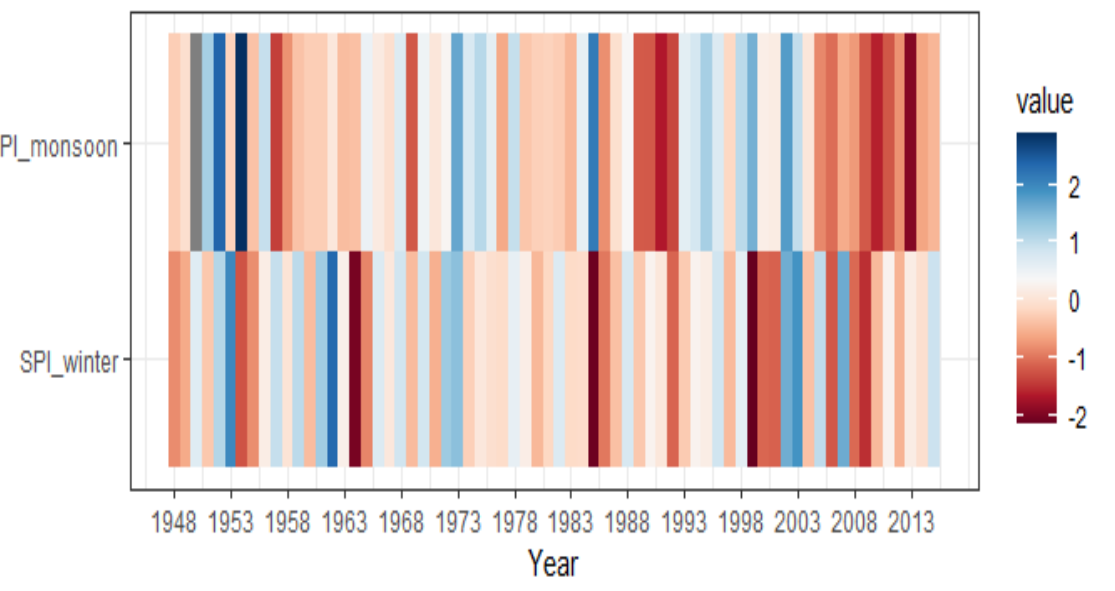
Figure 7. Drought heat map of Standard Precipitation Index SPI (SPI 1 to SPI 12) in the study area. The drought heat map showed the monsoon drought (four-month SPI in September) and winter drought (three-month SPI in February) (Figure 8). Results suggested that both monsoon and winter droughts occurred on a periodic basis, and after 2004 there were consecutive monsoon drought years in the study area. The wet/non-drought conditions (SPI > 0) were indicated by shades of light blue to dark blue and drought conditions (SPI < 0) were indicated by shades of light red to dark red (increasing drought intensity).